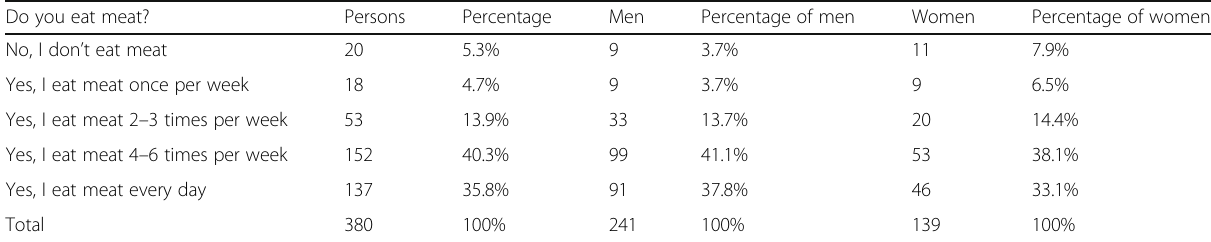
Table 2 Frequency of meat consumption in Sydney, 2018 Do you eat